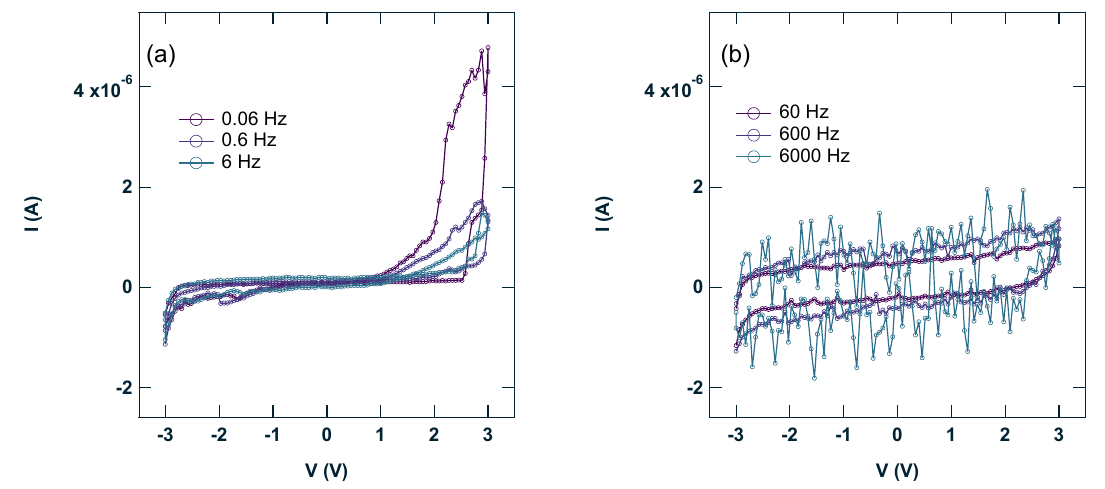
Figure 3. Plot of I vs. V as a function of scan frequency in the range of ( a ) 0.06–6 Hz and ( b ) 60–6000 Hz. Sweeping voltage range: ±3 V, and I cc : 1 × 10 −2 A.